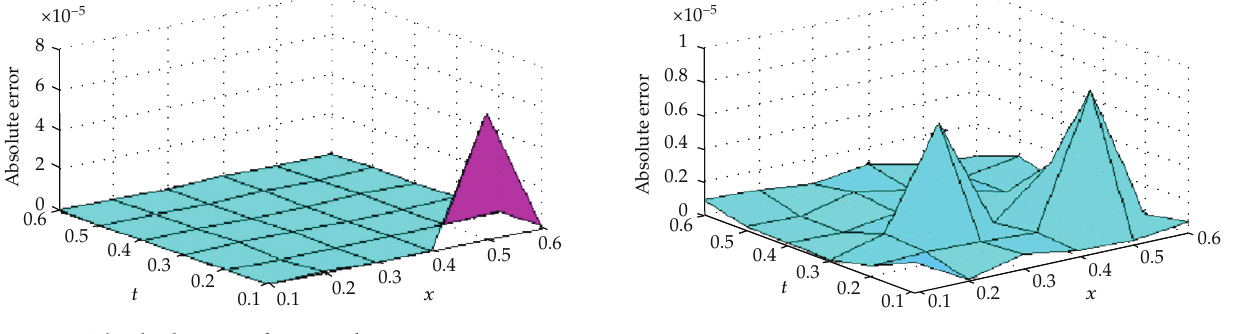
Figure 1: The absolute error for Example 10 at 0.1 ≤ 𝑥 , 𝑡 ≤ 0.6 . Figure 2: The absolute error for Example 11 at 0.1 ≤ 𝑥 , 𝑡 ≤ 0.6 .